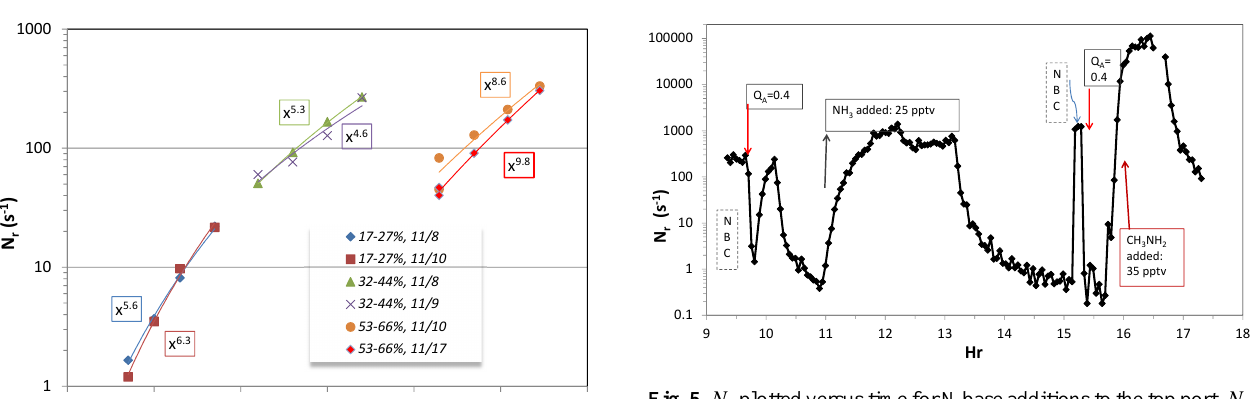
Fig. 5. N r plotted versus time for N base additions to the top port. N r is greatly affected for Q A = 0 . 4sLpm, 27%RH conditions where 0.05s − 1 is typical for pristine conditions. NBC was checked twice during the experiment (09:30 and 15:15) and undetectable, residual N base exhibited a significant effect. AmPMS showed a detectable amount of methyl amine during its